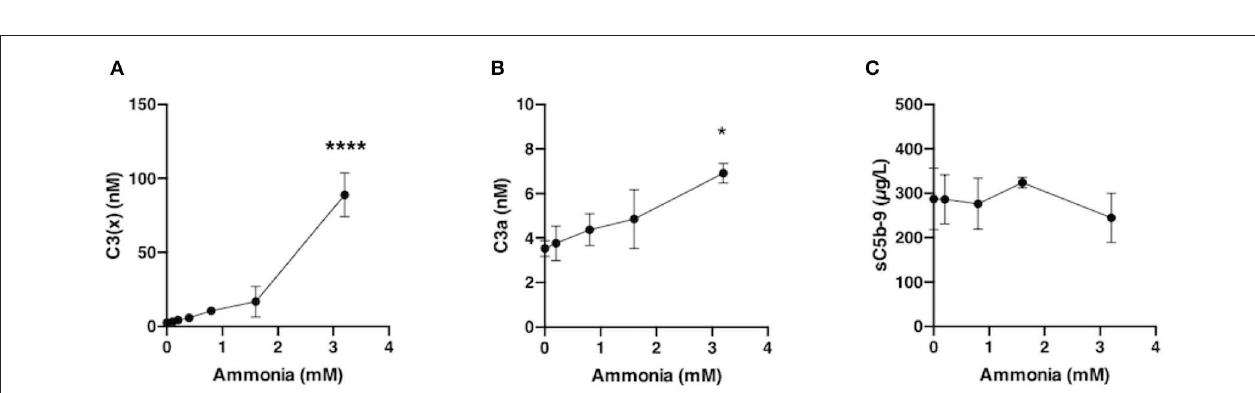
FIGURE 6 | Generation of C3(x) and complement activation induced by ammonia in human lepirudin plasma. Serial amount of ammonia (0–3.2mM) was incubated together with human plasma, and thereafter, C3(x) (A) , C3a (B) , and sC5b-9 (C) levels were examined. Data was collected from 3 donors and presented as mean ± SEM. Significant difference compared to control plasma without addition are indicated as * P < 0.05 and **** P < 0.0001.